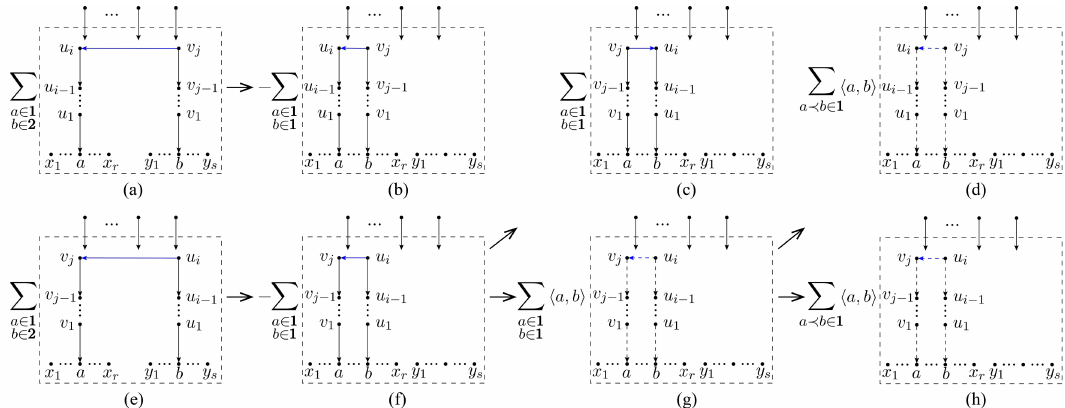
Figure 9 . A pair of graphs (b) and (f) in category-3, which are obtained from the expansions of spanning forests (a) and (e), only provide graphs (d) and (h). This is because after applying transformation-1 to graph (f), the resulting graph (c) cancels out graph (b), and the resulting graph (g) is further split into graphs (d) and